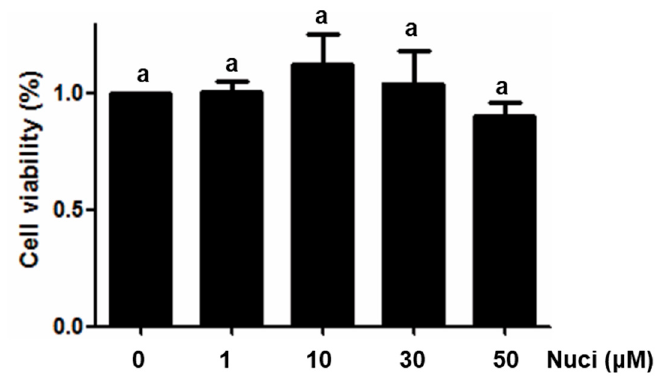
Figure 1. Cytotoxicity of Nuciferine on macrophage RAW264.7 cells. Cell viabilities of RAW264.7 cells treated with Nuciferine (0, 1, 3, 10 or 50 μ M), for 24 h, were measured by MTT assay.